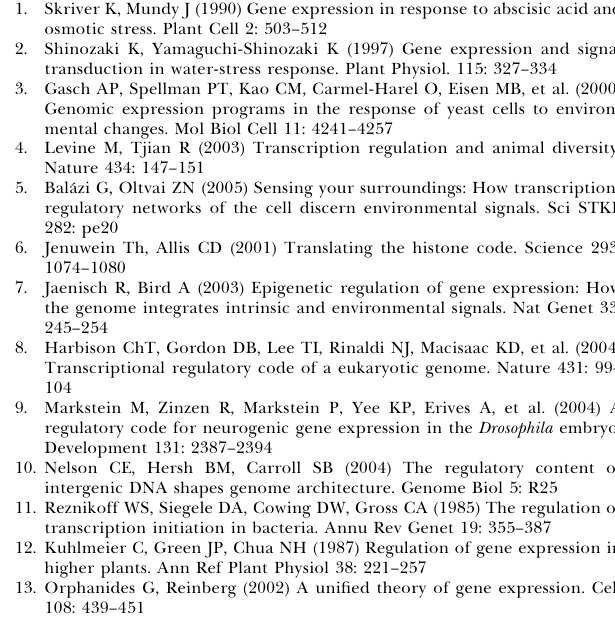
Figure S4. Motif Distribution in Upstream Intergenic Regions without Any Gene Overlaps (Green Histogram), with Possible Preceding Genes Falling into the 3,000-Nucleotide Intergenic Up- stream Region Regulatory motifs are less frequent in intra genic regions. Figure S5. Mean Number of cis -Elements in 500-Nucleotide Gene Upstream Regions and Associated Standard Error of the Mean as a